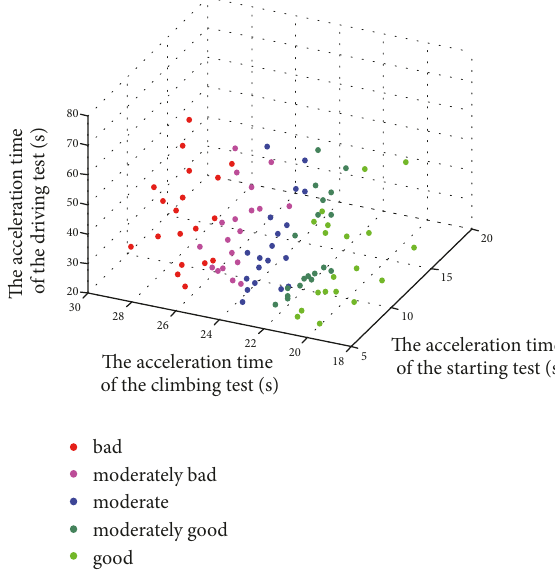
Figure 5: Scatter diagram of the overall subjective